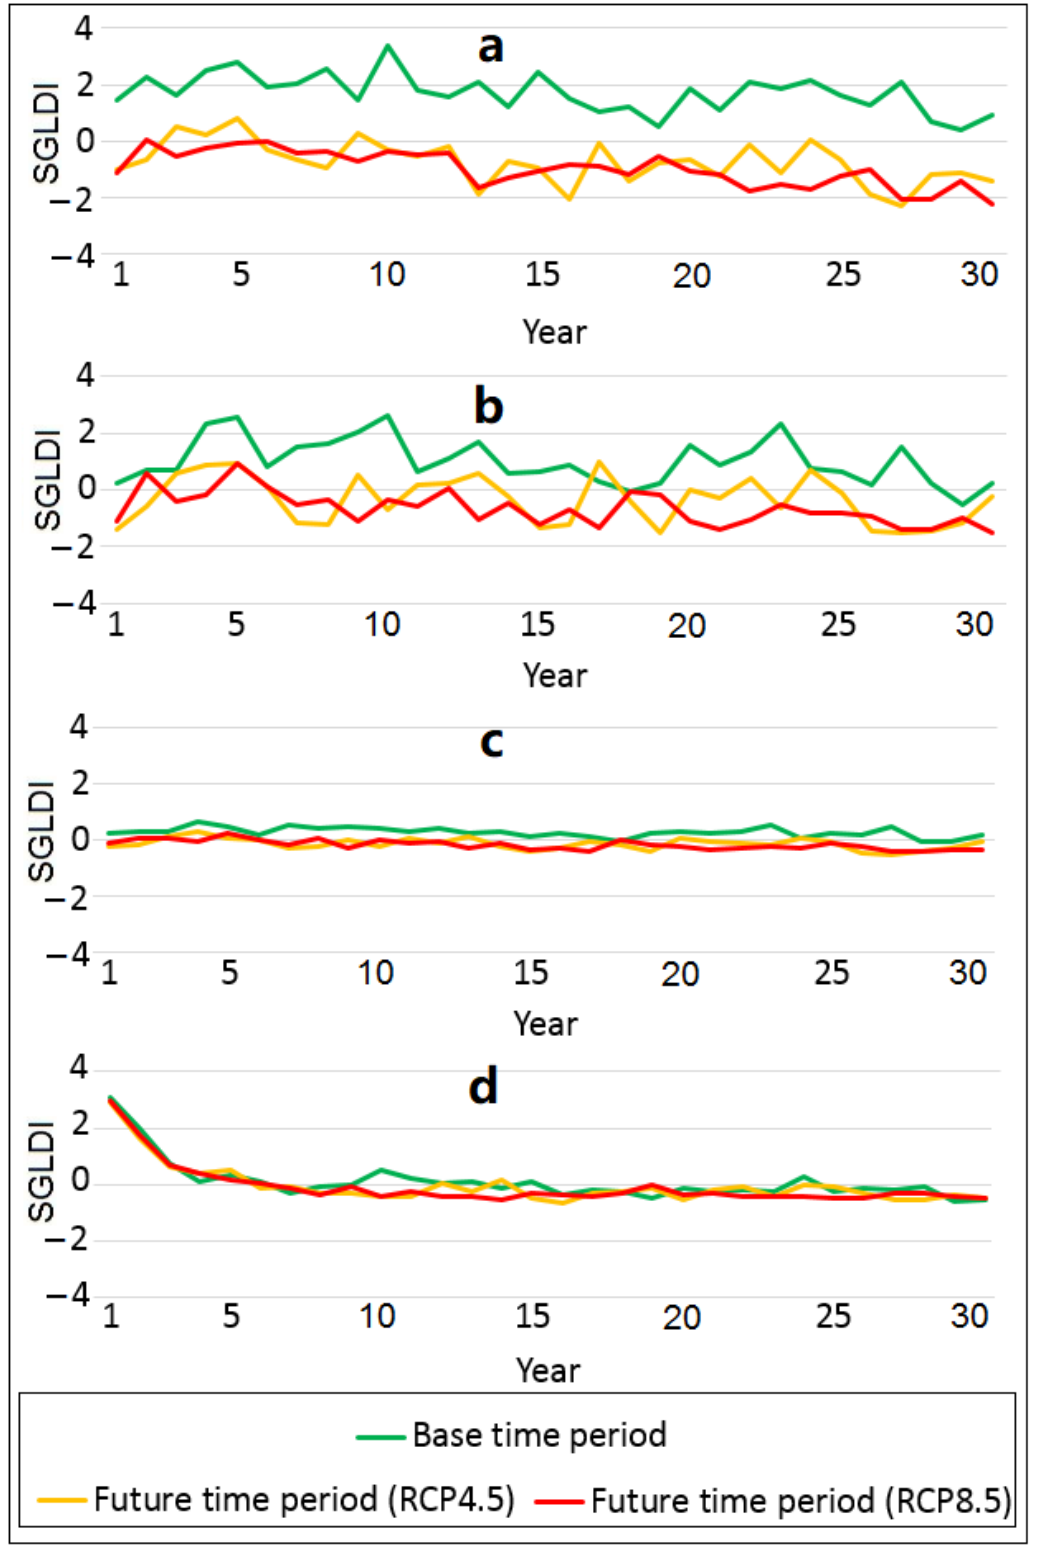
Figure 6. The SGLDI of the karst well W1 ( a ), W2 ( b ), W3 ( c ) and the Pali alluvial aquifer ( d ) in the base and future time periods, considering RCP4.5 and RCP8.5 (years 1–30 indicate 1961–1991, as to the base time period and 2021–2050, as to the future time